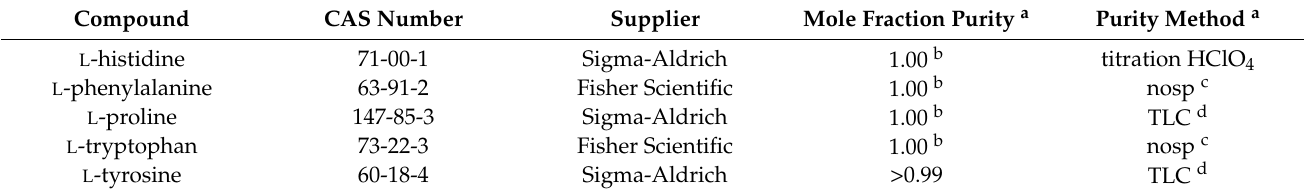
Table 5. Sample Table 5. Sample description.